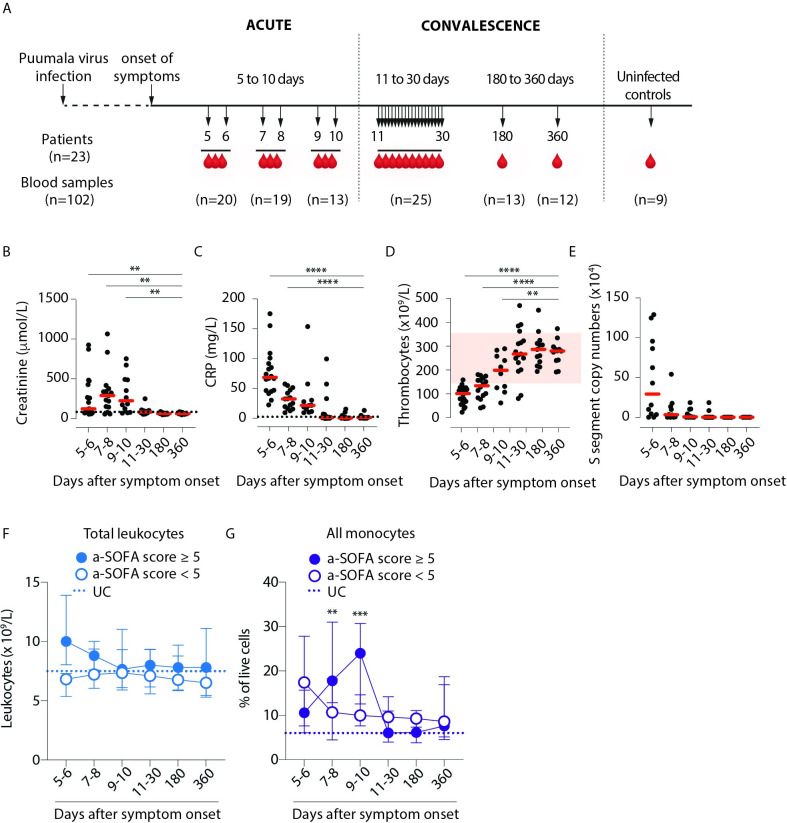
Viremic phase in Puumala virus-infected patients is characterized by thrombocytopenia, acute kidney injury and an overall increase in monocyte frequencies.(A) Longitudinal peripheral blood samples (n = 102) were collected from 23 patients with serologically-confirmed acute PUUV infection. Samples were obtained from the patients during acute infection (days 5–10) and convalescence (days 11–30, day 180 and day 360) as well as from 9 uninfected controls (UCs). Levels of (B) creatinine (μmol/L in plasma), (C) C-reactive protein (CRP, mg/L in plasma), (D) thrombocyte counts (109/L in blood) and (E) copy numbers of PUUV S segment in plasma (104/ml in plasma). Graphs show data from individual subjects and lines indicate median values. Dotted lines indicate reference values in healthy adults. Each dot represents an individual sample and red zone indicates reference range for thrombocyte counts in healthy adults (D). (F) Graph shows the total leukocyte counts (median ± interquartile range, IQR) during PUUV infection for patients stratified by severity as lower, i.e. a-SOFA score <5 (empty circles) or higher, i.e. a-SOFA score ≥5 (filled circles). (G) Graph shows median ± IQR monocyte frequencies to total live cells (classical + intermediate + nonclassical monocytes) during PUUV infection for patients stratified by severity as lower, i.e. a-SOFA score <5 (empty circles) or higher, i.e. a-SOFA score ≥5 (filled circles). Dotted line represents median values from UCs. Statistical differences between day 360 and other time points (B-E), and patients with lower and higher a-SOFA scores (F-G) were assessed using a generalized estimated equation (GEE) model in SPSS and differences were considered significant at p<0.05 (**p<0.01, ***p<0.001 and ****p<0.0001).